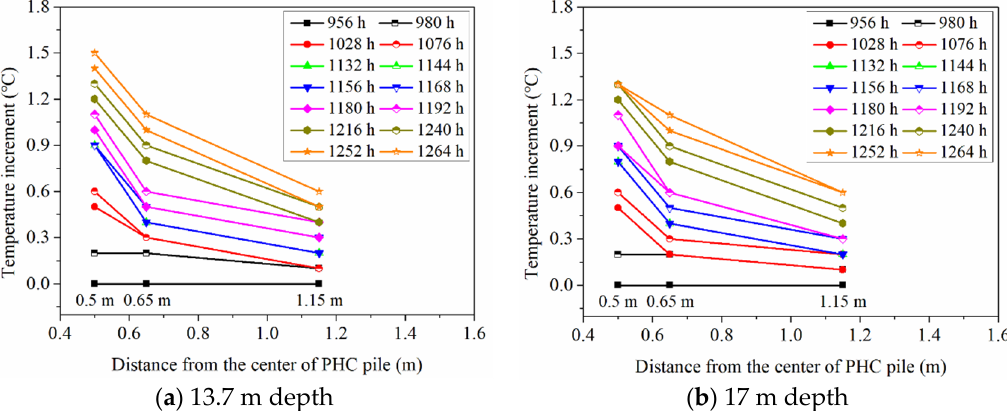
Figure 8. Ground temperature variation at various distances from the center of PHC pile.